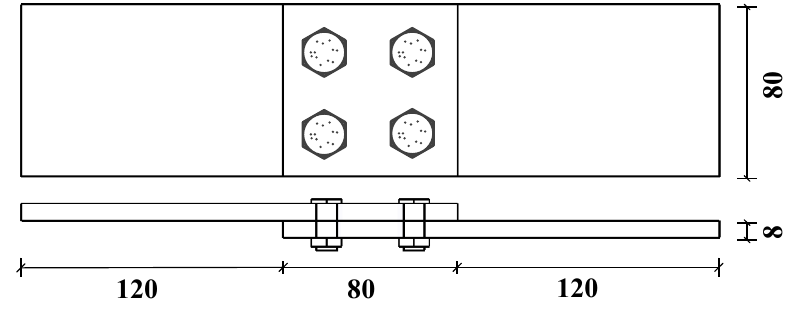
Figure 5. Bolted lap structure (mm). Table 2. The material parameters of components.